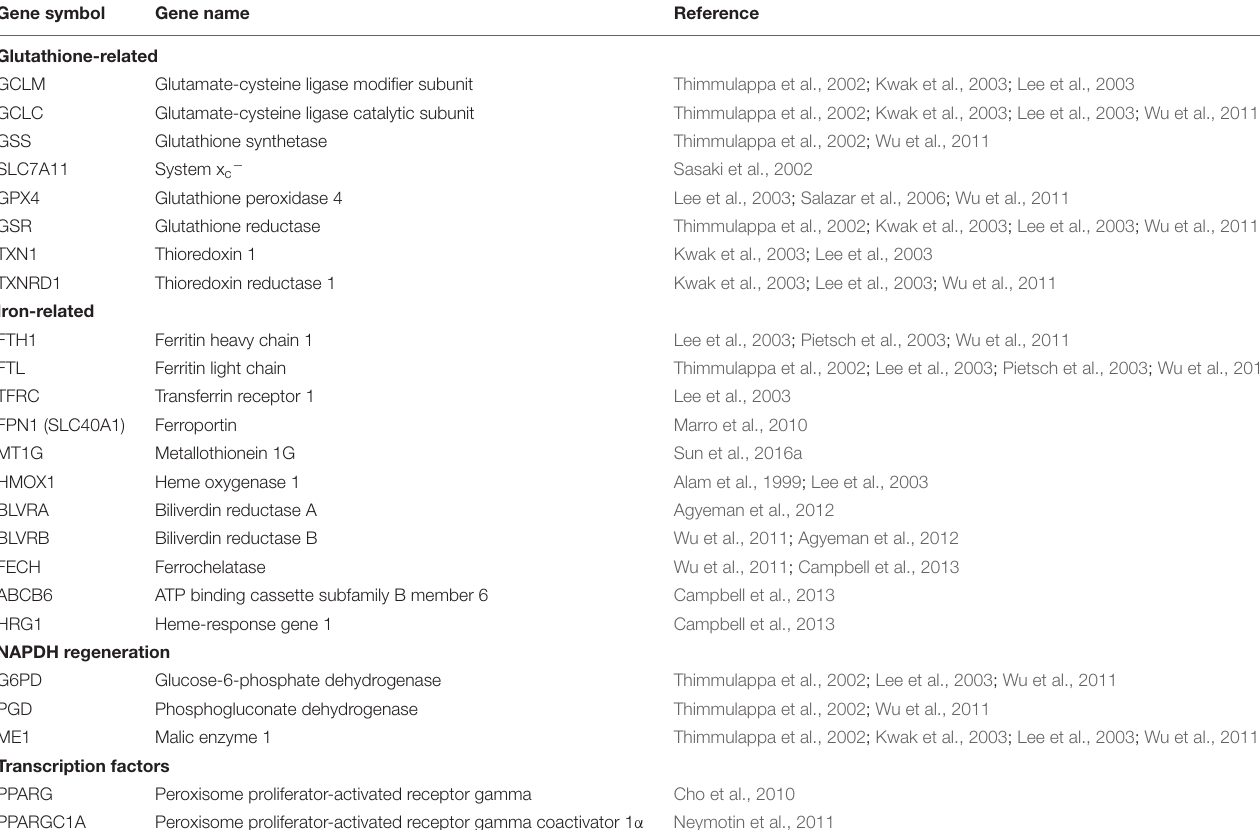
TABLE 1 | Ferroptosis-related genes that are transcriptionally regulated by